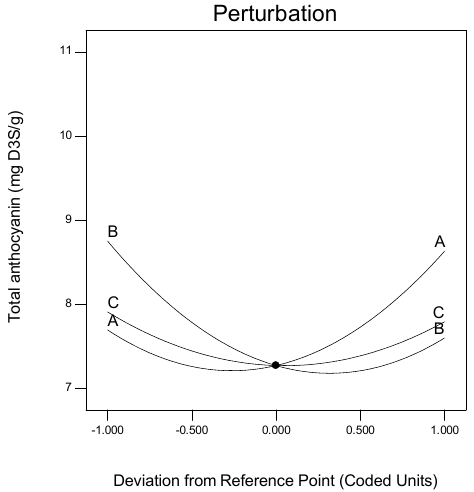
Figure 3. Perturbation graphic showing the effects of variables on total anthocyanin.